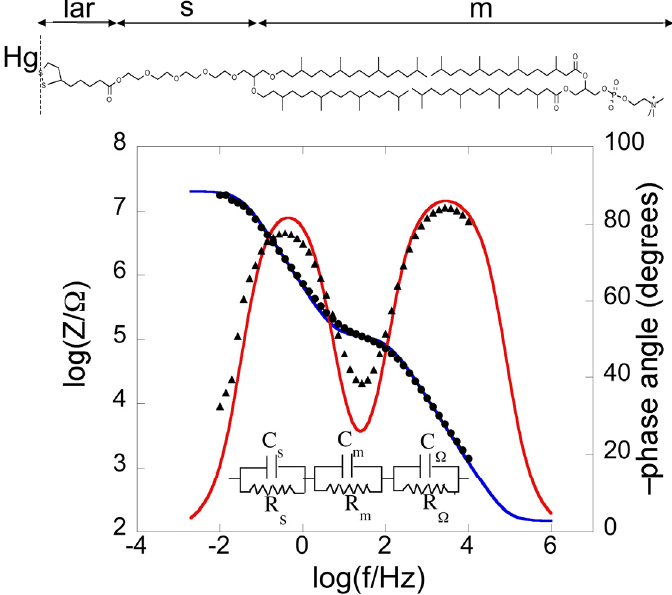
Figure 2. Plot of log| Z | (solid circles) and φ (solid triangles) against log f (Bode plot) for a mercury-supported DPTL/DPhyPC bilayer incorporating gramicidin from its 1 × 10 − 7 M solution in aqueous 0.1 M KCl at − 0.60 V vs. Ag|AgCl|0.1M KCl. The blue and red